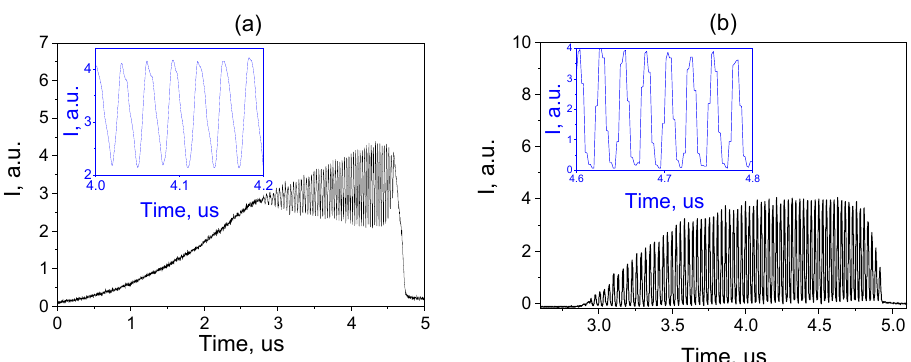
Figure 11. The 1st Stokes ( a ) and the 2nd Stokes ( b ) pulse shapes at gain modulation (40 W pump power, repetition rate 27.22 kHz). Inset: zoomed sub-pulses.